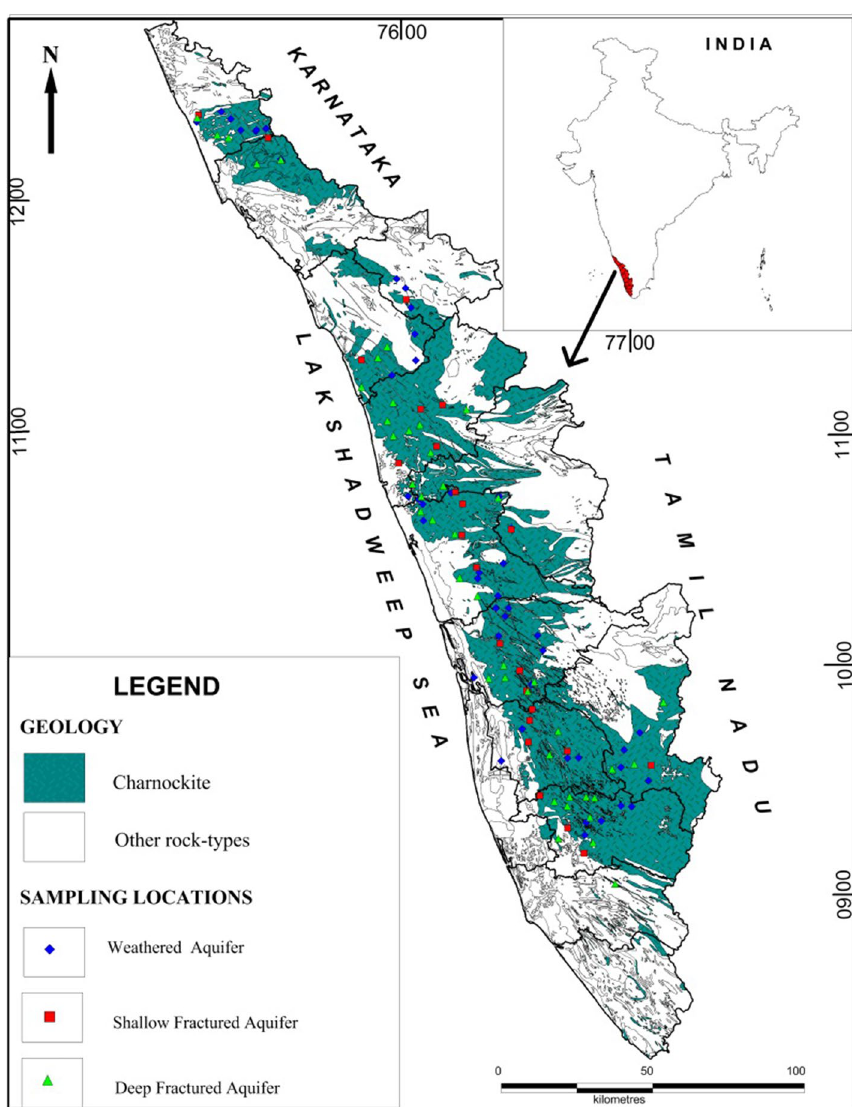
Fig. 1 Location map of study area showing sampling loca- tions (after GSI